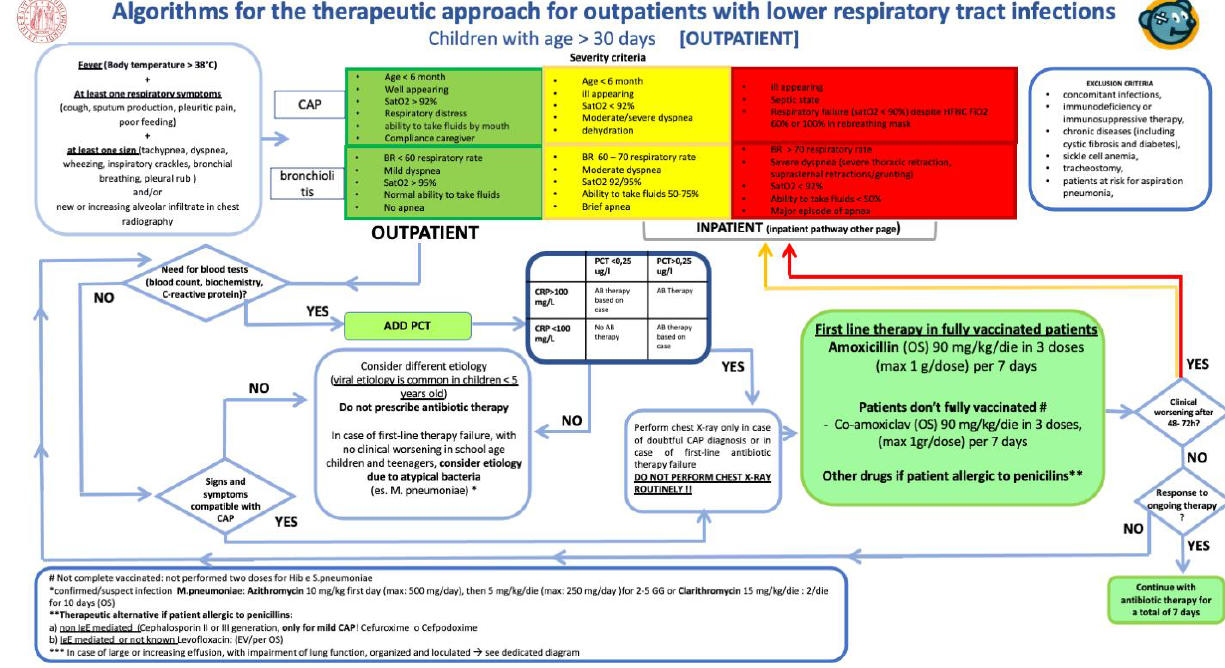
Figure A1. Clinical pathway for lower respiratory tract infection for children older than 30 days of age. Padova, 2019.